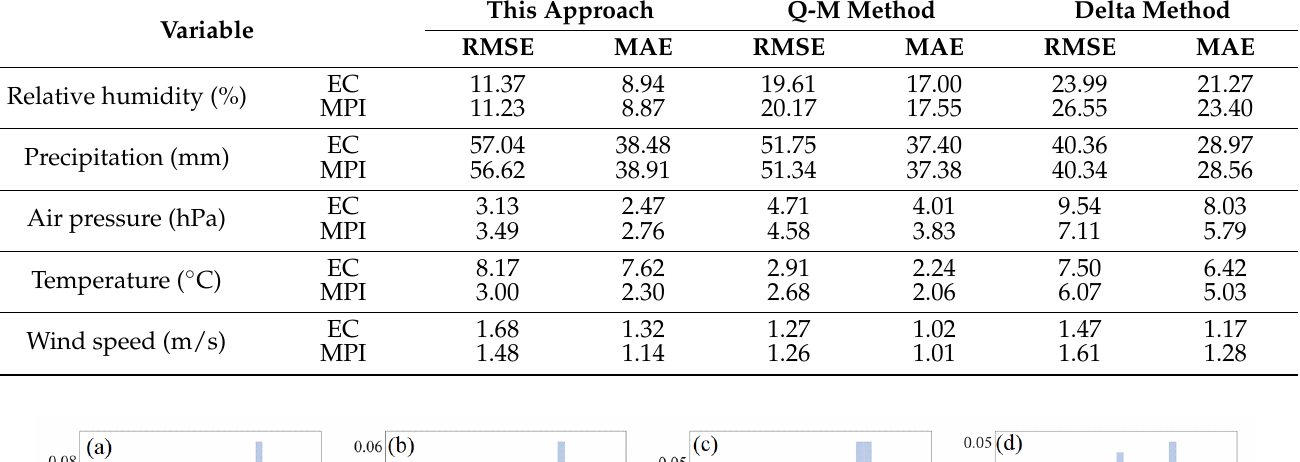
Table A5. Comparison of performance of the three comparative adjustment methods in terms of mean RMSE and MAE over the 36 QTP sites after the second adjustment (2000–2014) of adjustment based on two GCM simulations (EC and MPI). Same as Table 7 except for the second adjustment (2000–2014).